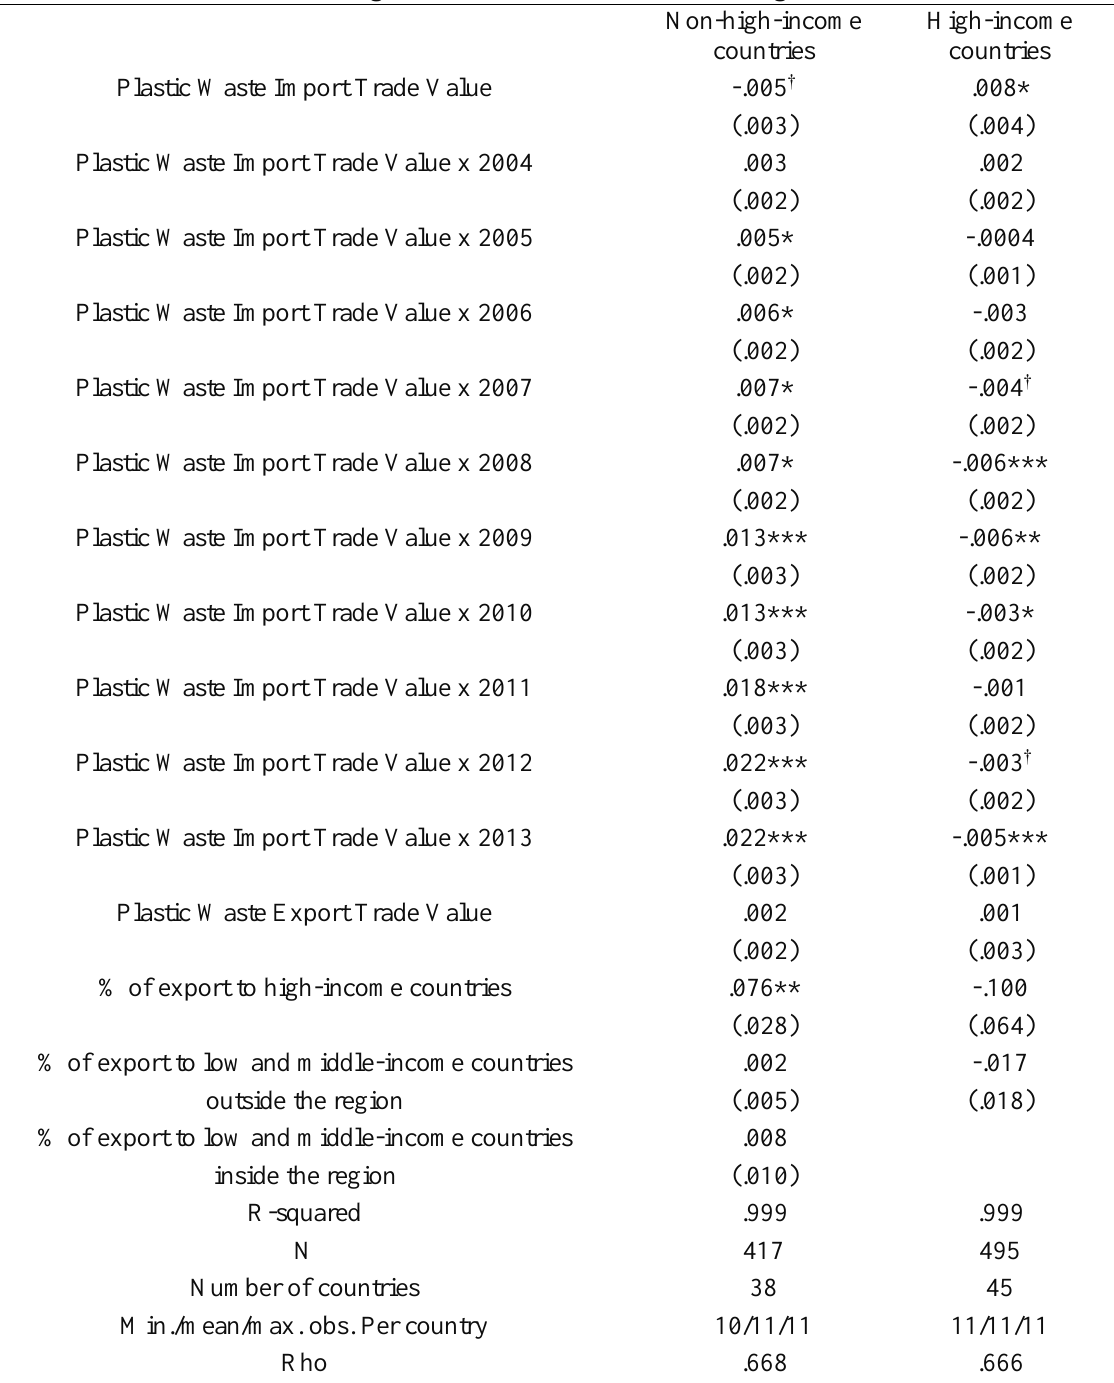
Table 8 Regression of GDP per capita, 2003-2013, on Plastic Waste Import Trade Value and Other Selected Independent Variables: Two-Way Fixed Effects PW Model Estimates for 40 Non-High-Income Countries and 45 High-Income